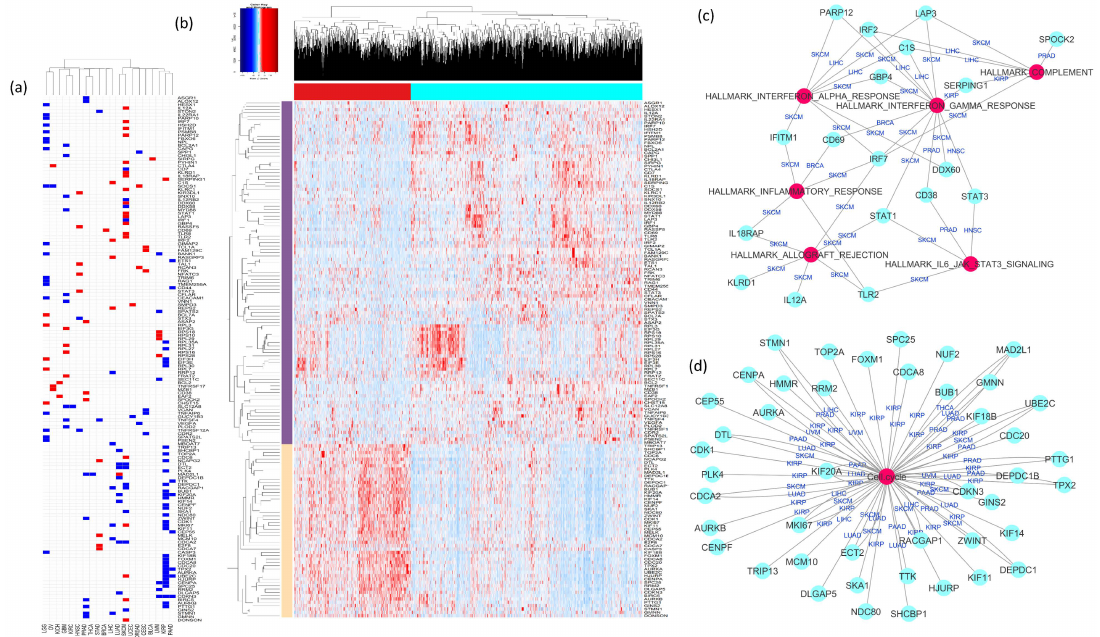
Figure 3. ( a ) Using a computational pipeline of an elastic net model and univariate Kaplan–Meier analysisfor20TCGAtumortypes,